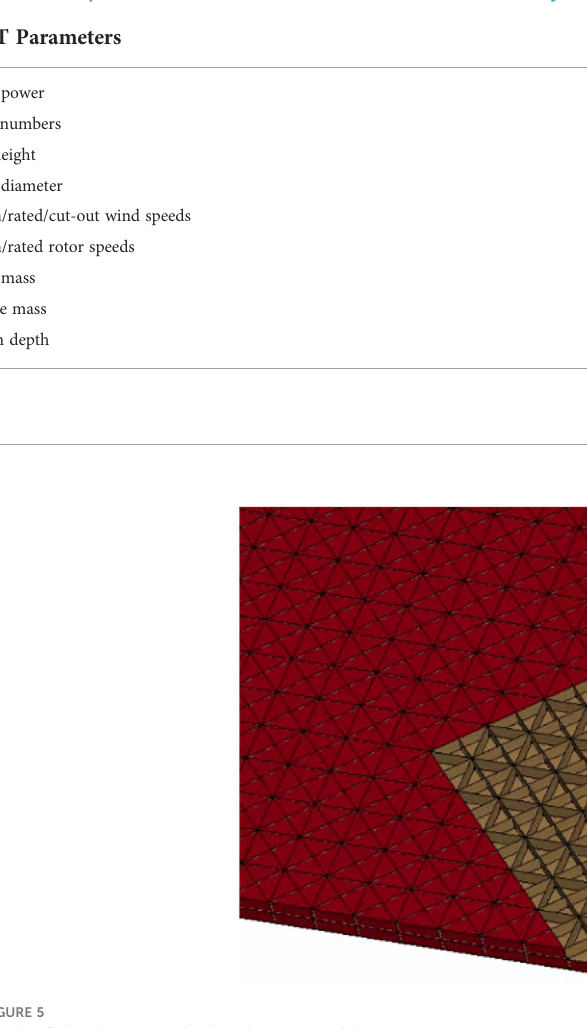
TABLE 1 Main speci fi cations of the DTU 10 MW OWT (Velarde and Bachynski, 2017).